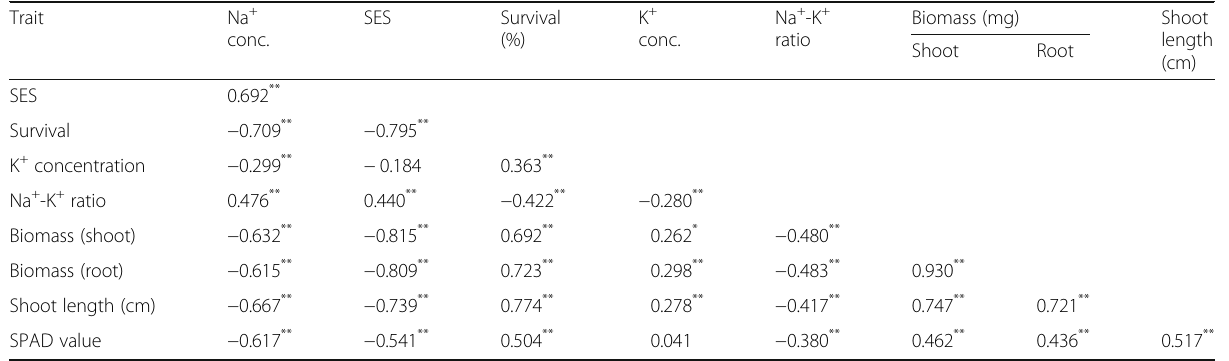
Table 1 Correlation coefficients for the associations among Na + concentration, overall phenotypic score (SES), survival, K + concentration, Na + -K + ratio, shoot and root biomass, and shoot length in F 2:3 population of a cross between Capsule (salt tolerant) and BR29 (salt sensitive) subjected to salt stress at seedling